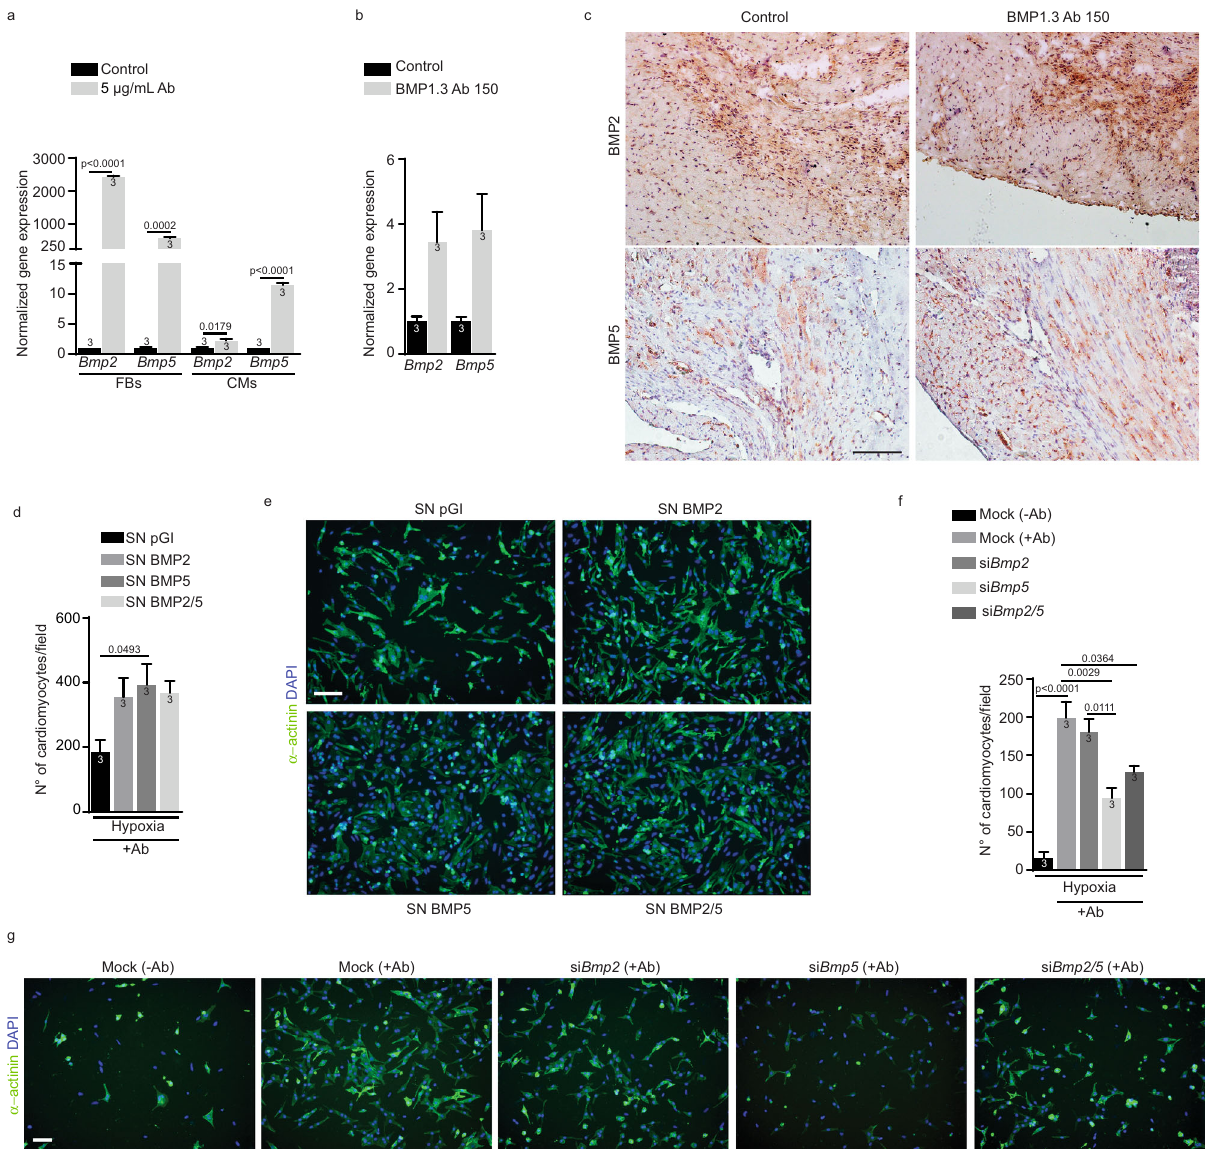
Fig. 4 Bmp2 and Bmp5 are upregulated upon treatment with anti-BMP1.3 antibody and exert cardioprotective activity. a Quanti fi cation of the expression levels of Bmp2 and Bmp5 in primary cardiac fi broblasts and cardiomyocytes cultured in hypoxic conditions in the absence of treatment (control) or treated with anti-BMP1.3 antibody (5 µ g/ml), normalized to Gapdh . b Quanti fi cation of the expression levels of Bmp2 and Bmp5 in the heart of mice subjected to MI in the absence of treatment (control) or after injection of anti-BMP1.3 antibody (150 µ g/kg). c Representative images from tissue section of infarct area of untreated rats (control) or treated with anti-BMP1.3 antibody (150 µ g/kg) stained with either anti-BMP2 or anti-BMP5 antibody (brown) and hematoxylin (violet) to visualize nuclei. d Quanti fi cation of living cardiomyocytes cultured in hypoxic conditions expressed as number of cardiomyocytes per fi eld and exposed to the indicated enriched supernatants collected from CHO transfected with control plasmid (pGI) or plasmid for the overexpression of BMP2 and/or BMP5. e Representative images of rat neonatal cardiomyocytes cultured in hypoxic conditions and exposed to the indicated treatments. Cardiomyocytes were stained with anti- α -actinin antibody and nuclei with DAPI. f Quanti fi cation of living cardiomyocytes cultured in hypoxic conditions and exposed to the indicated treatments. g Representative images of rat neonatal cardiomyocytes cultured in hypoxic conditions in the absence of treatment ( − Ab) or treated with anti-BMP1.3 antibody ( + Ab) and transfected with the indicated siRNAs (mock = scramble siBMP5). Data in a , b , d and f are shown as mean ± s.e.m. Sample number is indicated inside or above each bar. Statistical signi fi cance was determined using unpaired, two-sided t -test in a , b or one-way ANOVA followed by Dunnet ’ s in d or Tukey ’ s multiple comparison test in f . Scale bar in c , e and g is 100 µ m. Source data are provided as a Source Data fi in vivo, as shown by reduced levels of pSmad2 in the nuclei of Among the TGF β target genes is Lox . The role of Lox proteins fi broblasts within the scar tissue and, also in this case, signi fi cant in collagen crosslinking is well known 11 and was recently con- fi rmed by the prevention of liver and lung fi brosis using anti- downregulation of TGF β target genes. Finally, recombinant Loxl2 antibodies 11,43 . Our data indicate that anti-BMP1.3 inhi- BMP1.3 increased Smad2/3 promoter activity in a luciferase bition signi fi cantly downregulated Lox expression both ex vivo reporter assay, while anti-BMP1.3 antibody exerted opposite, and in vivo, and reduced collagen crosslinking in the heart after inhibitory effect.